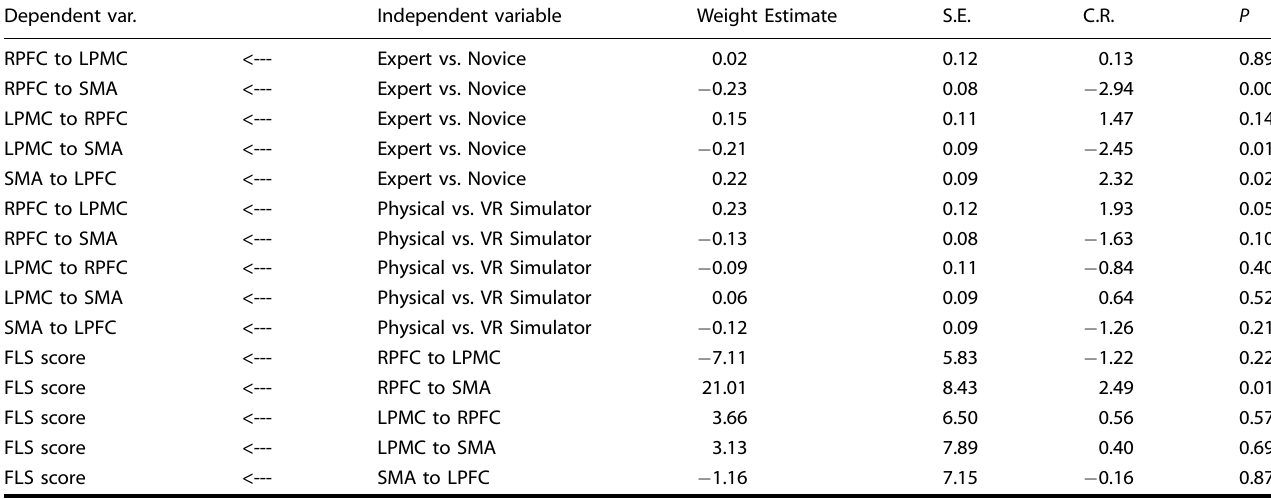
Table 1. Regression weight estimates for path analysis of the FLS score (grayed rows: signi fi cant after controlling for a false discovery rate of 0.05 with Benjamini – Hochberg adjustment).